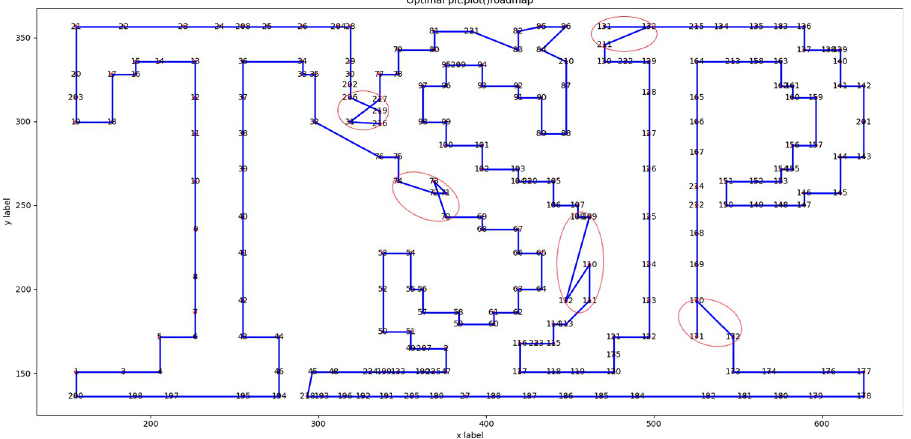
Fig 4. The optimal route of Tsp225 output by ABSQL